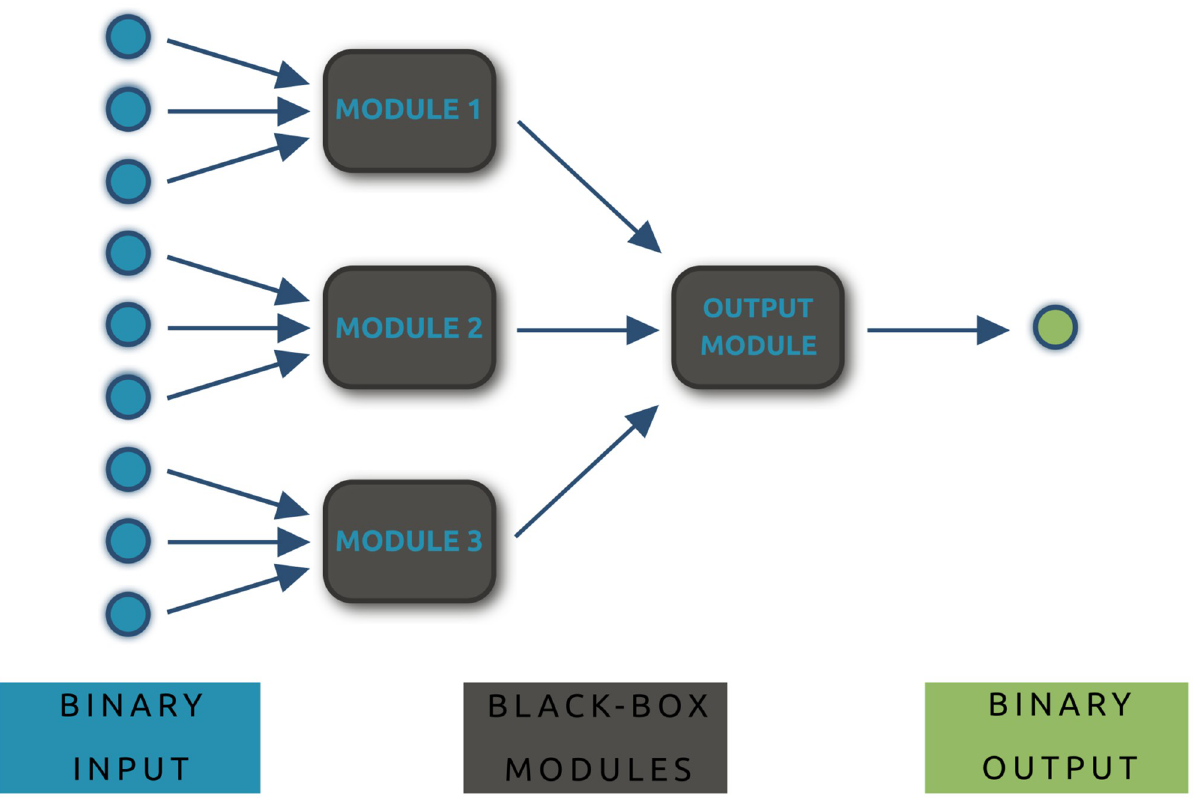
Fig 1. A tree-structured hybrid network. The network maps binary input variables x 2 {0, 1} 9 to binary outputs y 2 {0, 1}. Three first-layer black- box modules each have separate input variables, and a single black-box module processes the partial outputs of the first layer to compute the overall output of the network, which can then be interpreted as a decision for one of the two considered